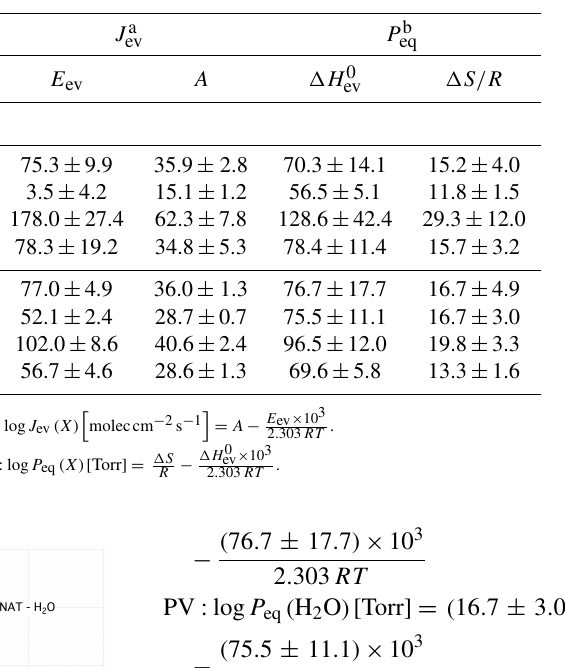
Table 4. Synopsis of thermodynamic ( P eq ) and kinetic ( J ev ) parameters of the Arrhenius and van’t Hoff representation of data from Figs. 2, 4, 8 and 9.